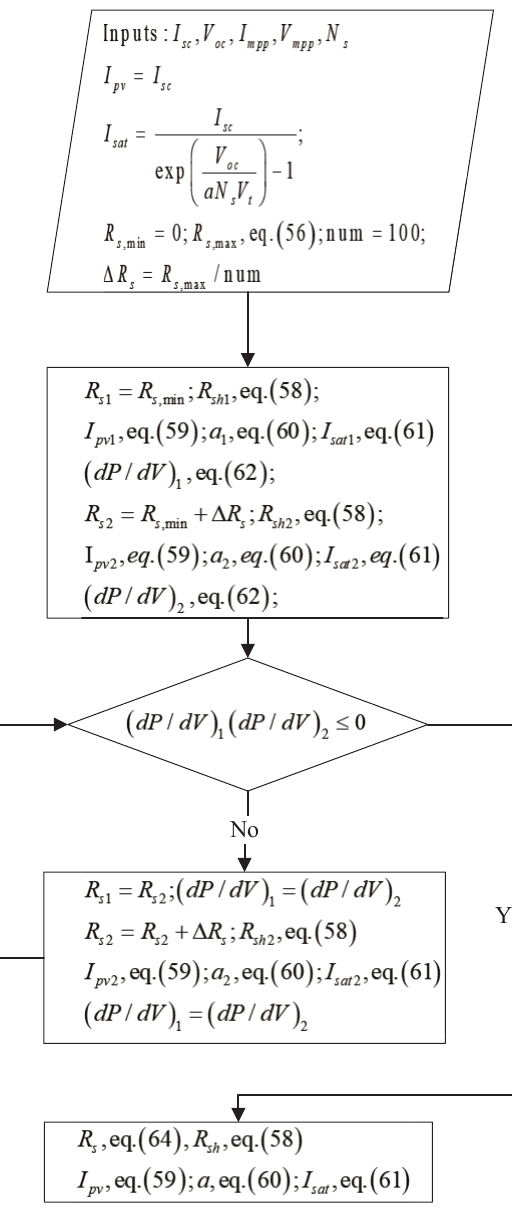
Figure 3. The flowchart to obtain model